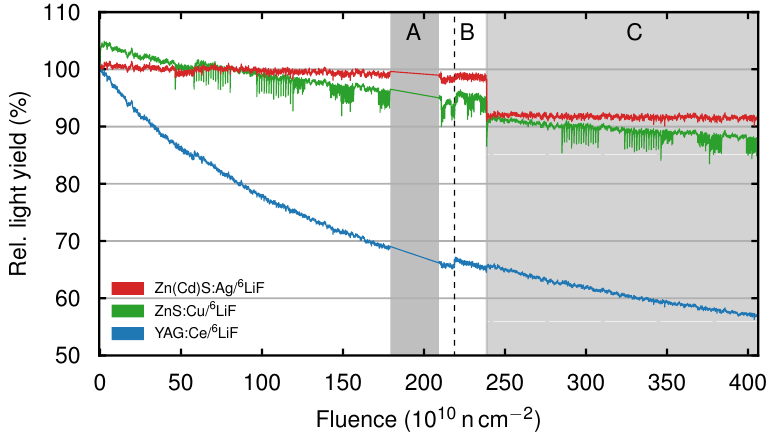
Figure 3. Light yield of ZnS (green), ZnCd (red) and YAG (blue) relative to their respective light yield at t i = 0s dependent on the total deposited neutron fluence. In area A, the screens were exposed to a total neutron fluence of 3 10 11 ncm − 2 , but no measurements were performed. The dashed line B × denotes a pause of 12h were the 6 LiF-based screens were not exposed to neutrons. During this pause, we measured the Gd-based scintillation screens. The scintillation screens were heated to 70 ◦ C during the fluence deposition in area C.